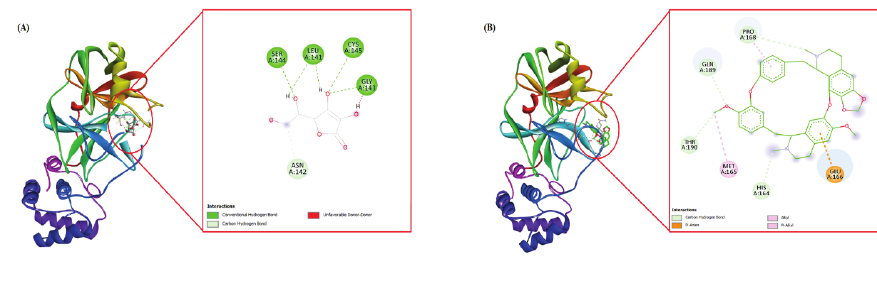
Figure 3 : Molecular interaction between (A) ascorbic acid and (B) cepharanthine against SARS-CoV-2 main protease